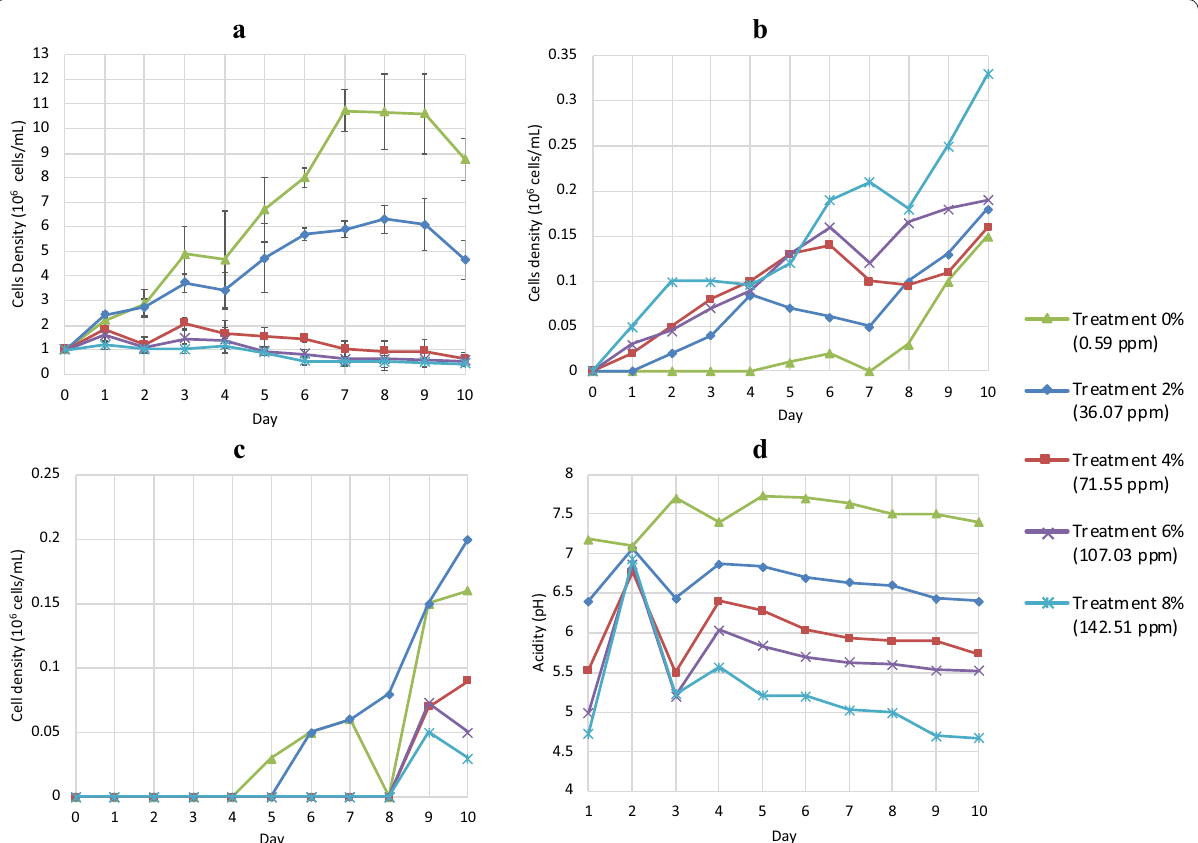
Fig. 3 Five treatments of CO 2 concentration during aeration fluid consisting of 0.59, 36.07, 71.55, 107.03 and 142.51 ppm for (a) Nannochloropsis sp. growth curve with one sigma standard deviation, (b) Nannochloropsis sp. cell death rate curve, (c) contaminant growth, and (d) acidity level (pH) of Nannochloropsis